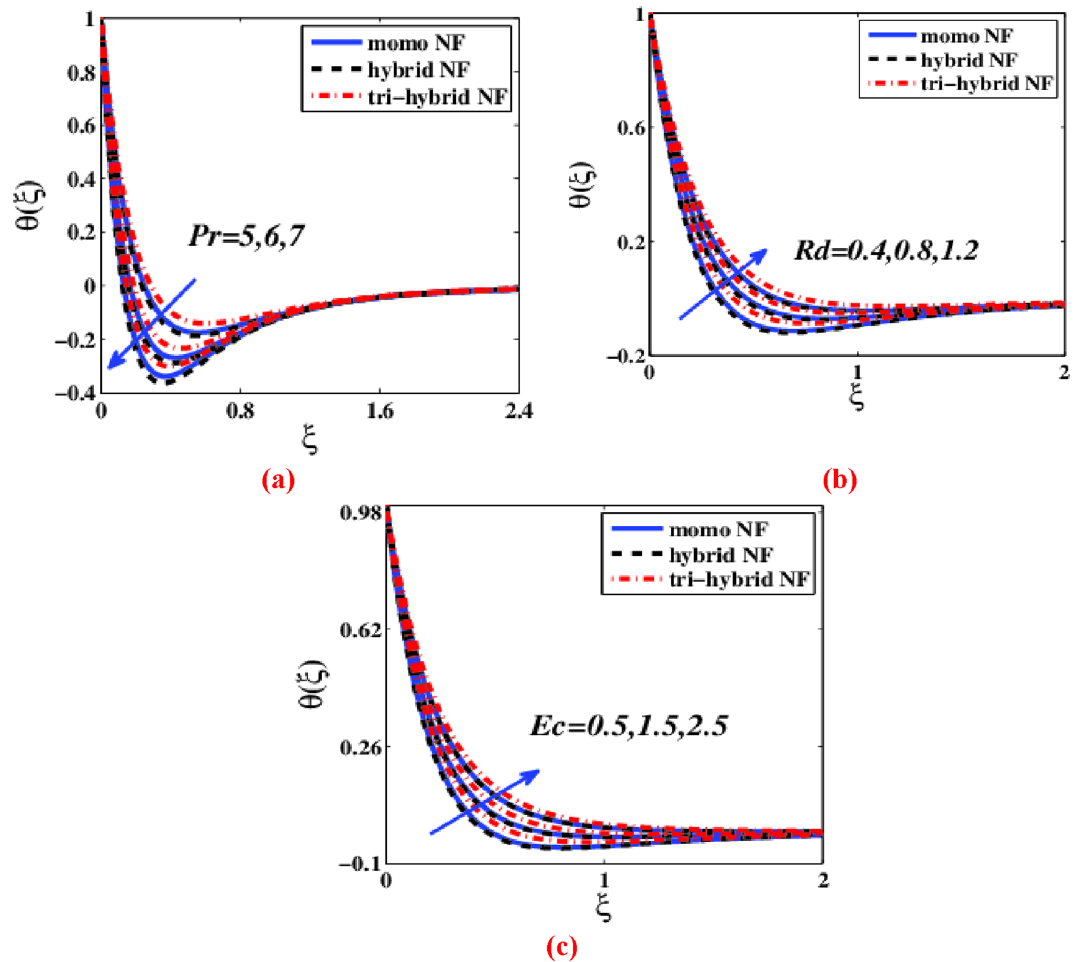
Figure 7. Impact of ( a ) Pr , ( b ) Rd and ( c ) Ec on θ(ξ)